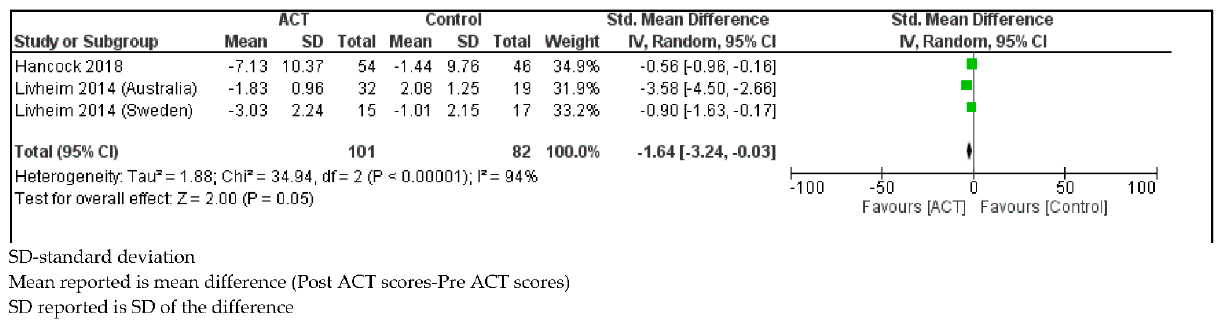
Figure 7. Forest plot comparing avoidance and fusion scores between children with SHCN who received ACT and children with SHCN who received no treatment.